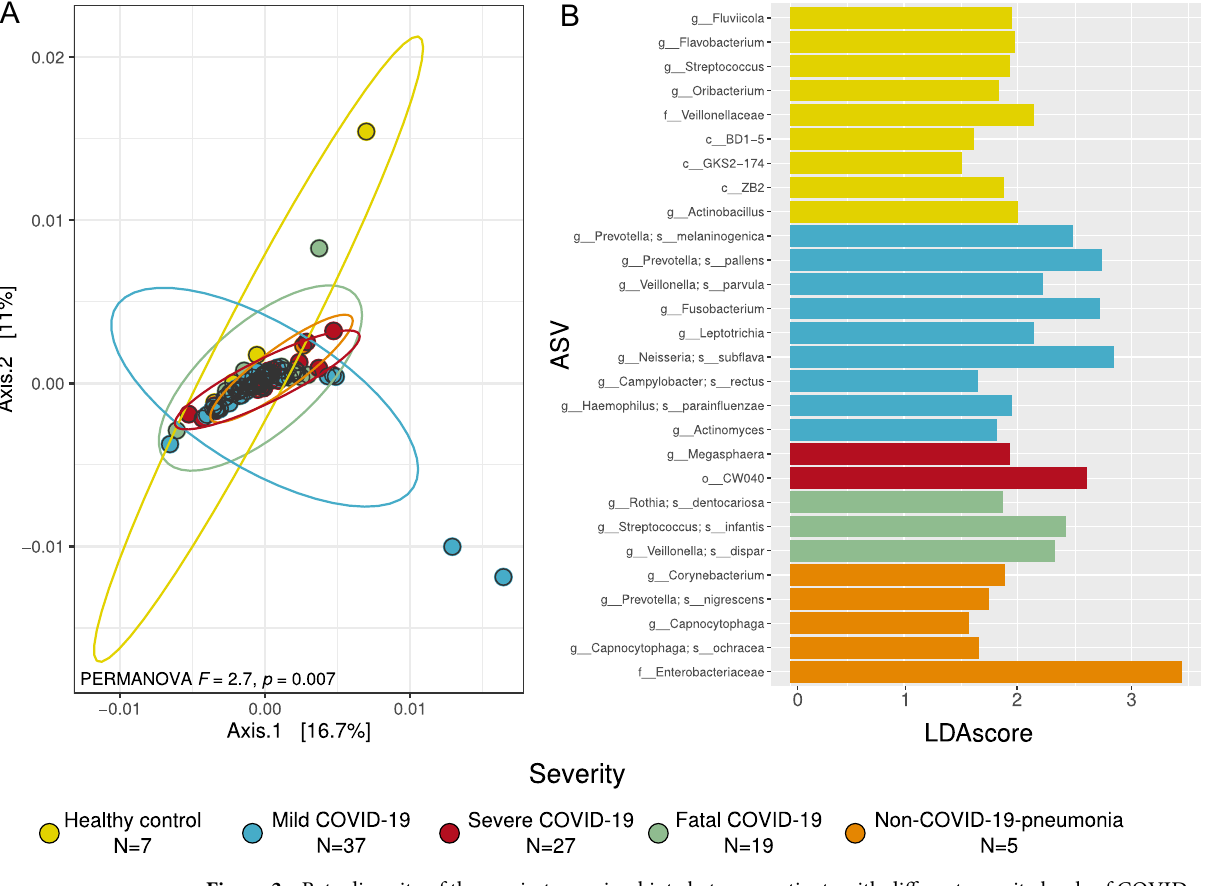
Figure 3. Beta diversity of the respiratory microbiota between patients with different severity levels of COVID- 19 and controls. ( A ) Principal Coordinates Analysis (PCoA) with weighted Unifrac distance and PERMANOVA result that test differences in the community arrange between groups. Each color represents an analyzed group specified in the legend. ( B ) Differentially abundant taxa for each group obtained through LefSe analysis. Only features with a LDA score higher than 1.5 and a p < 0.01 were included. ASV Amplicon Sequence